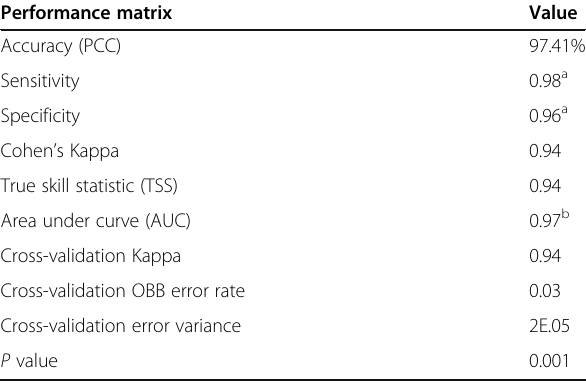
Table 2 Model validation metrics including model OOB error, sensitivity, specificity, Kappa, TSS, AUC, and significance ( P ),